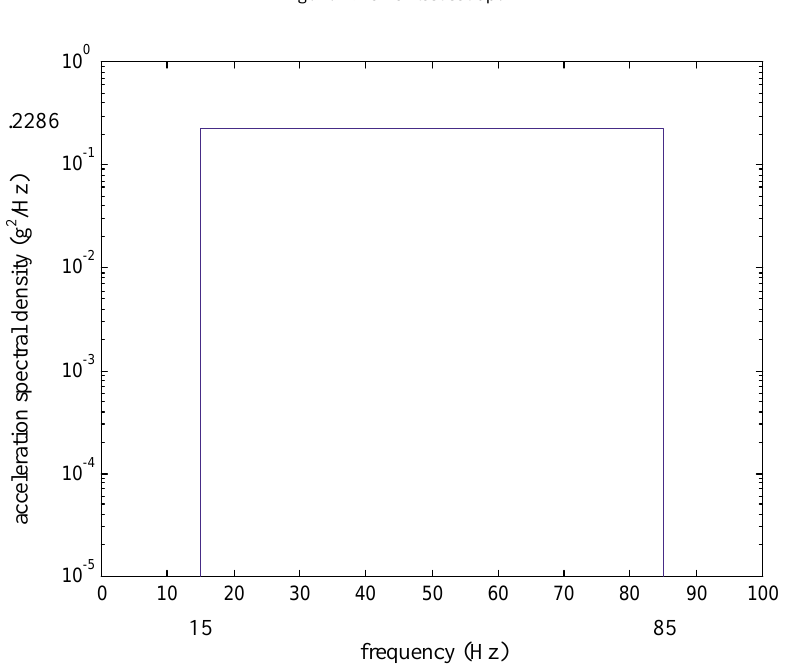
Fig. 5. Random vibration input acceleration spectrum-uniaxial